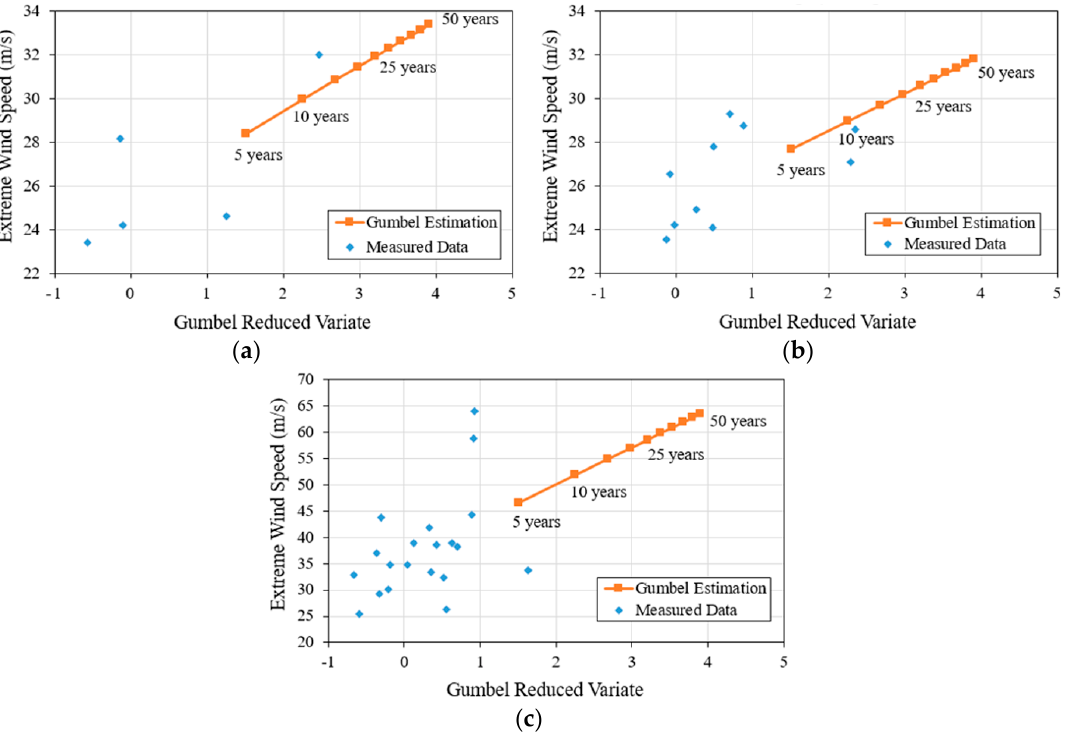
Figure 7. Estimation of EWS ( a ) Deokjeok-do; ( b ) Baengnyeong-do; ( c ) Seo-San.